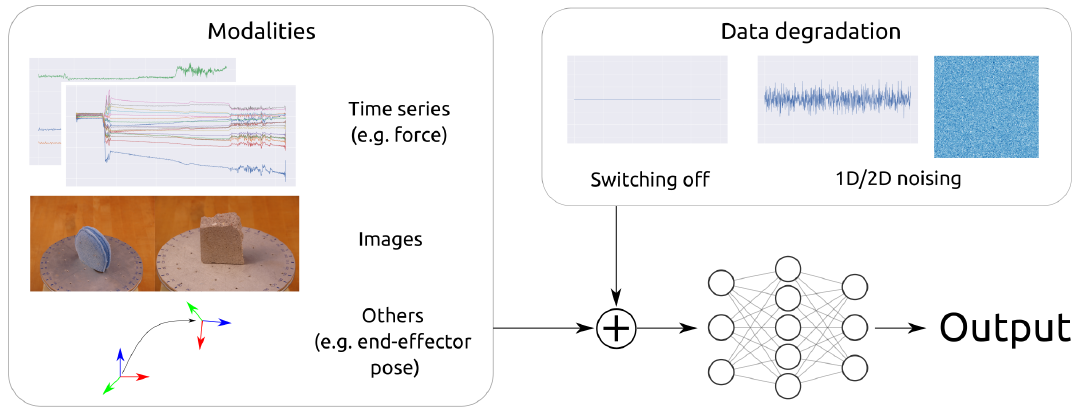
Figure 1. Experimental setup. We tested four different methods of multi-modal fusion and verified their robustness on a variety of data degradation scenarios common in